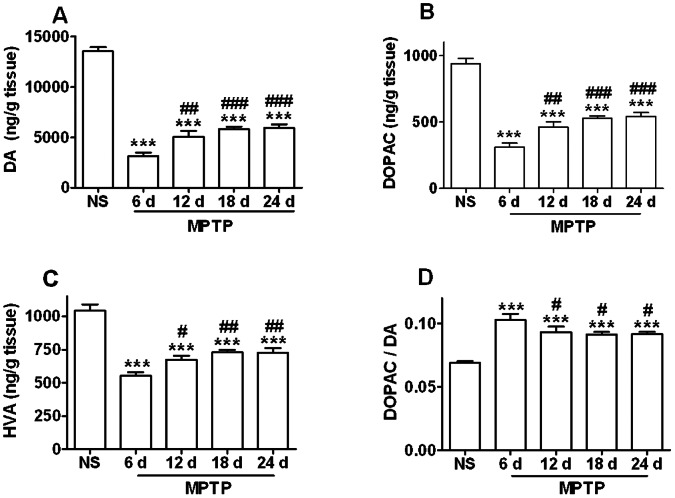
MPTP decreases striatal content of DA and its metabolites and increases the DA turnover.(A) DA. (B) DOPAC. (C) HVA. (D) DA turnover. *** p<0.001 vs. NS group; #
p<0.05, ##
p<0.01, ###
p<0.001 vs. MPTP group on day 6. n = 6∼7.